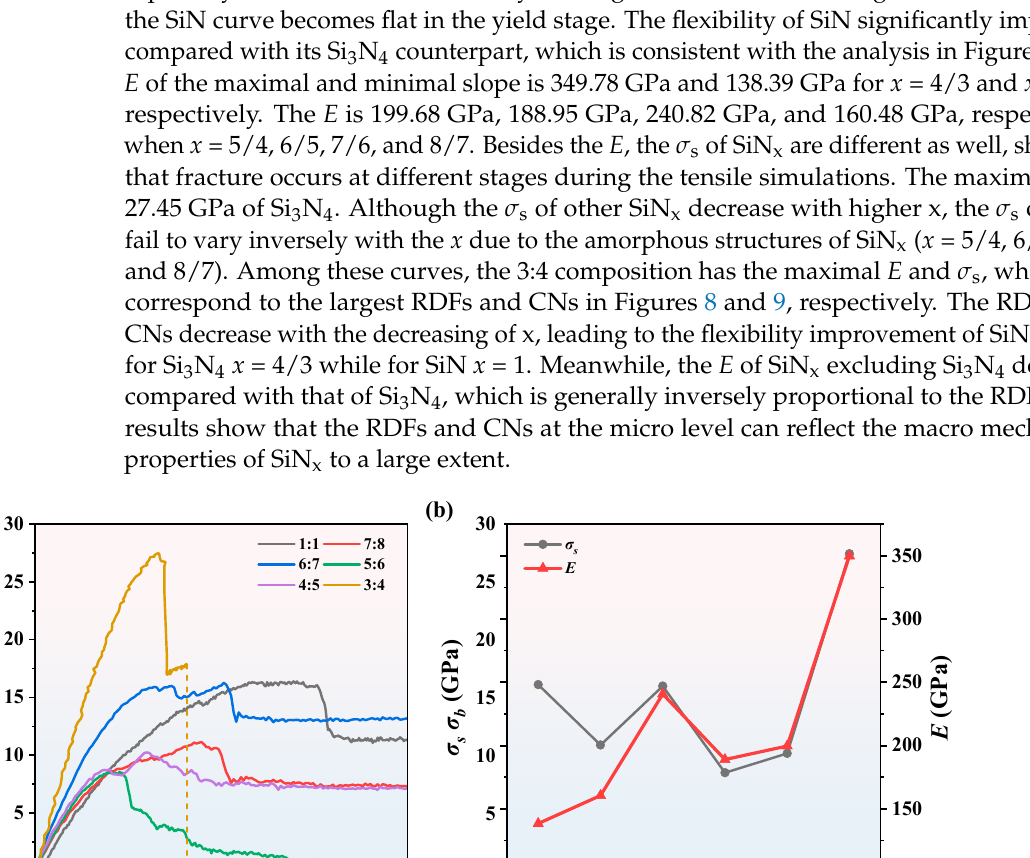
x at 300 K. ( b ) The mechanical properties of SiN x